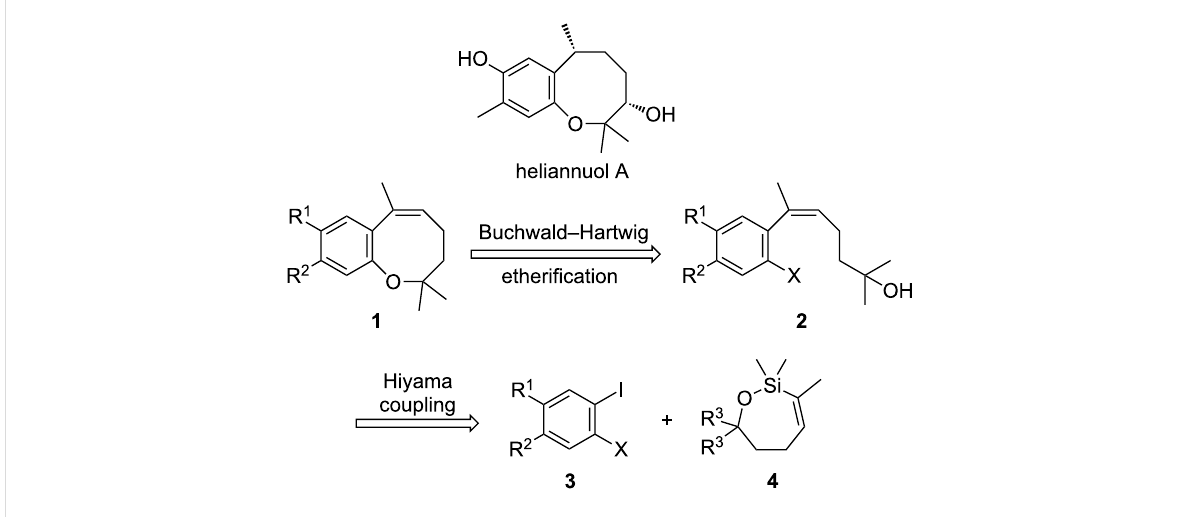
Figure 1: Retrosynthetic analysis of heliannuol